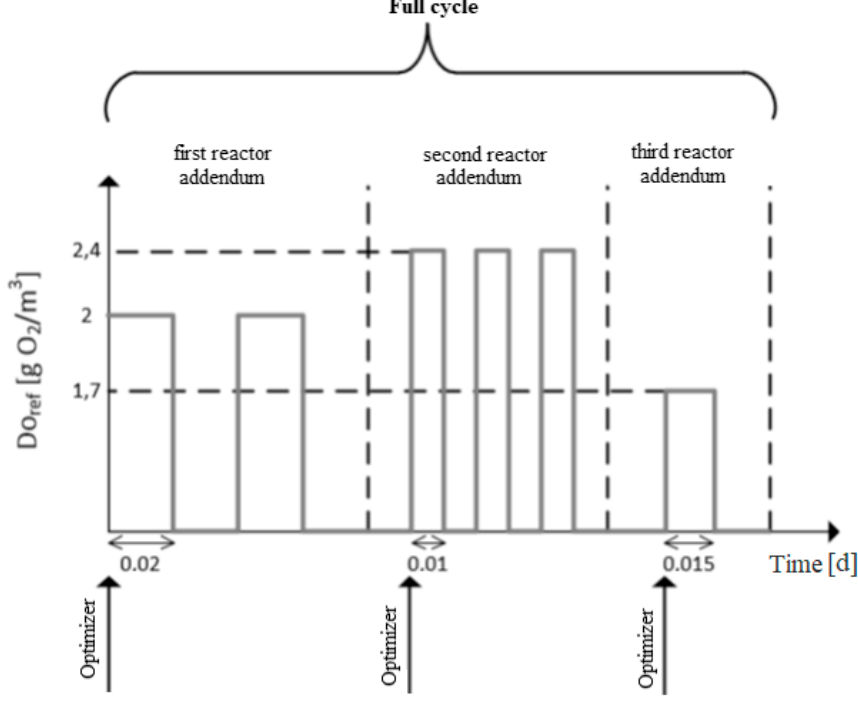
Figure 6. Example of DO ref trajectory.